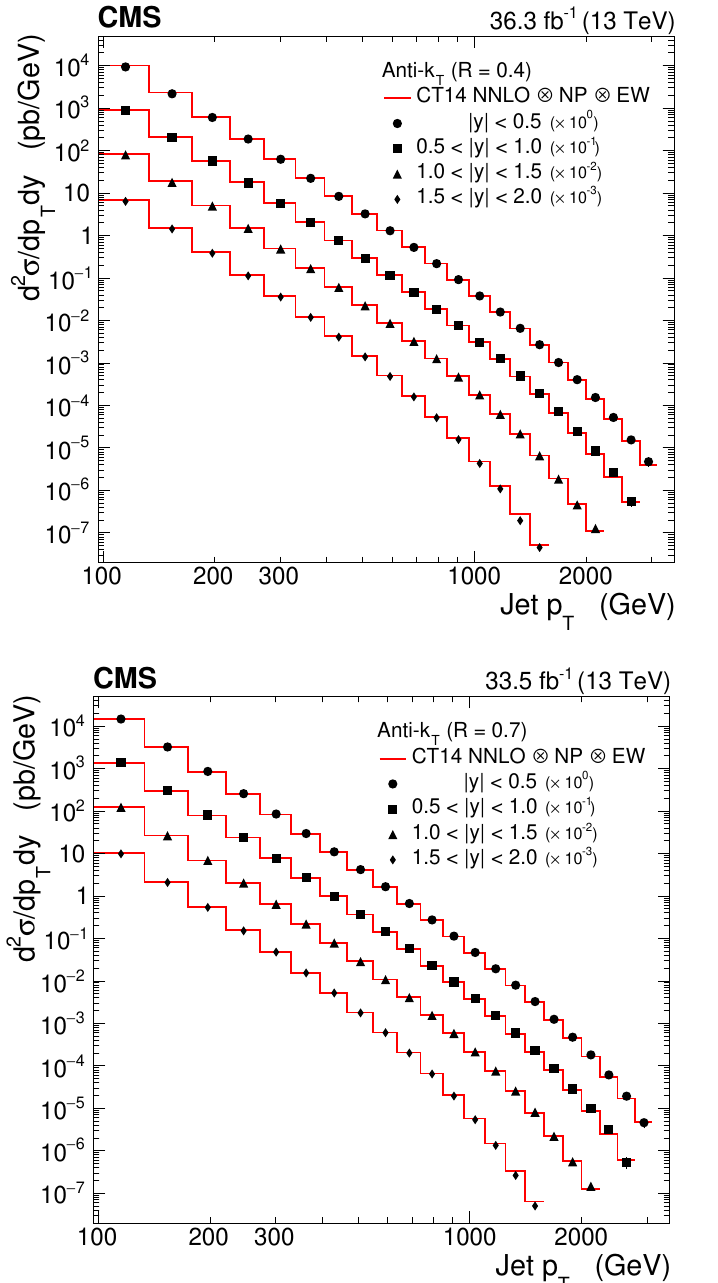
Figure 6 . The inclusive jet production cross sections as a function of the jet transverse momentum measured in intervals of the absolute rapidity | y | . The cross section obtained for jets clustered p T using the anti- k algorithm with R = 0 . 4 (0.7) is shown on the upper (lower) plot. The results in T different | y | intervals are scaled by a constant factor for presentation purpose. The data in different | y | intervals are shown by markers of different style. The statistical uncertainties are too small to be visible; the systematic uncertainties are not shown. The measurements are compared with fixed-order NNLO QCD predictions (solid line) using CT14nnlo PDF and corrected for EW and NP